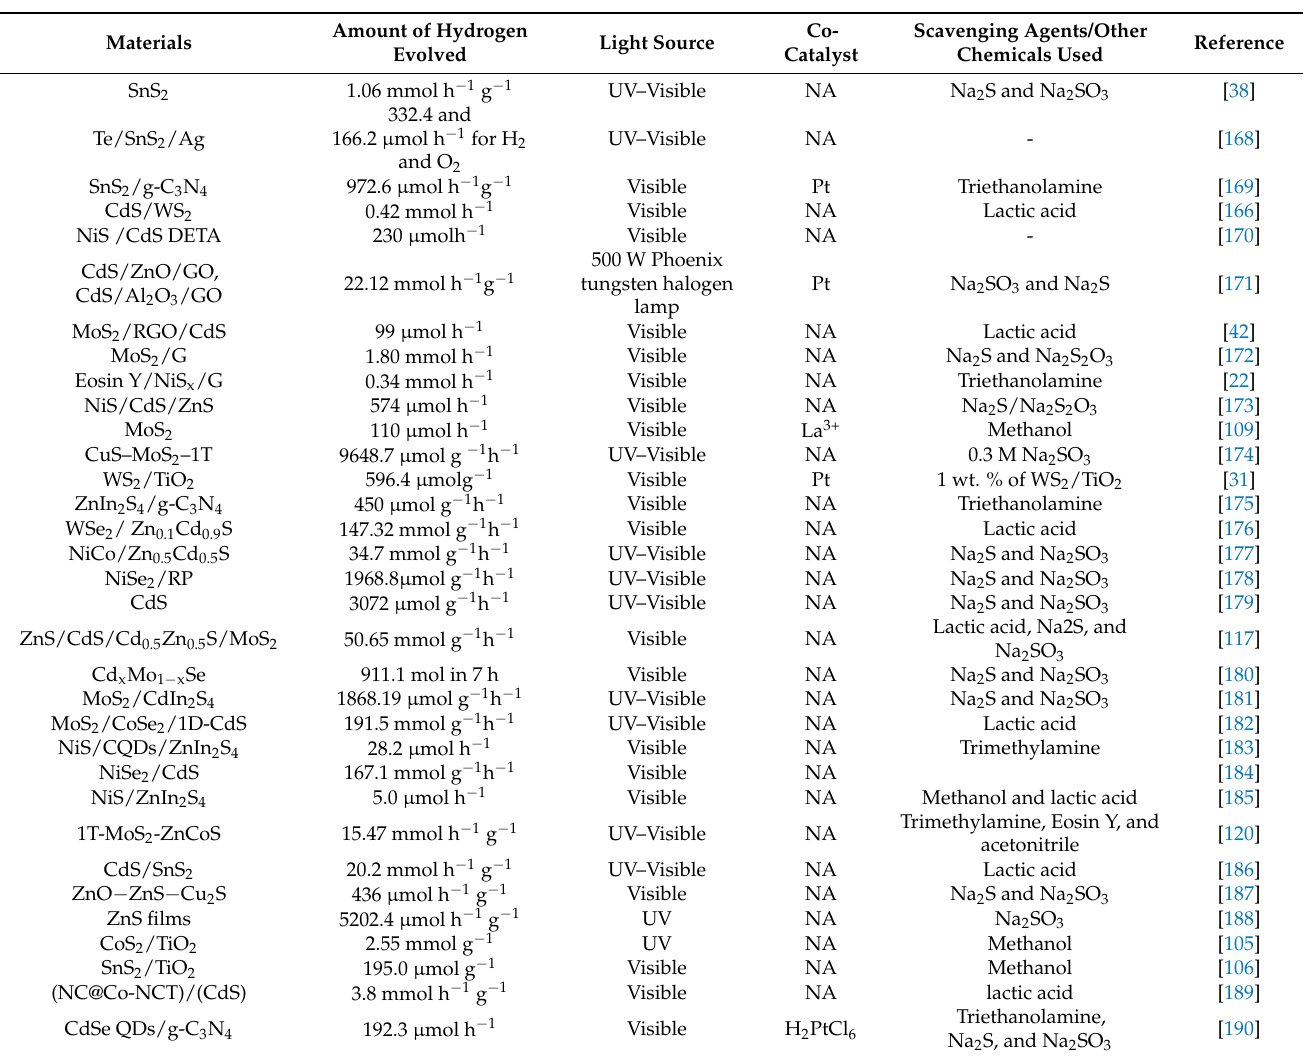
Table 4. Photocatalytic hydrogen evolution by using different TMC photocatalysts, the experimental conditions used, and the respective